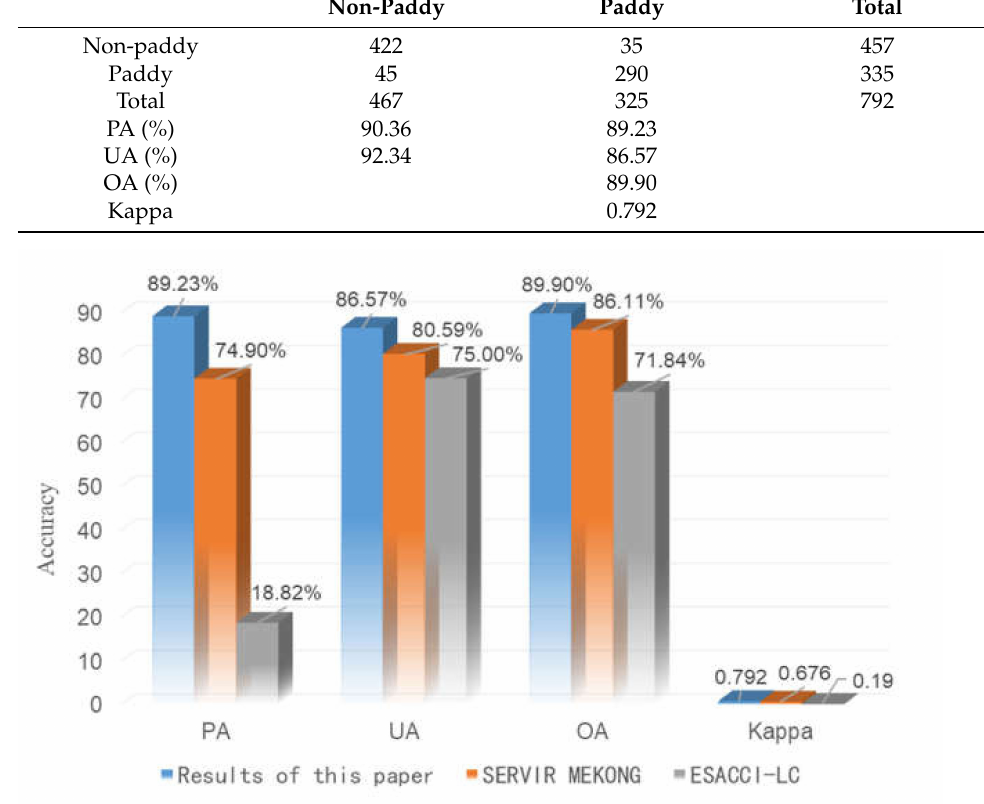
Figure 14. Comparison of the accuracies of the extraction results of the proposed method and the existing